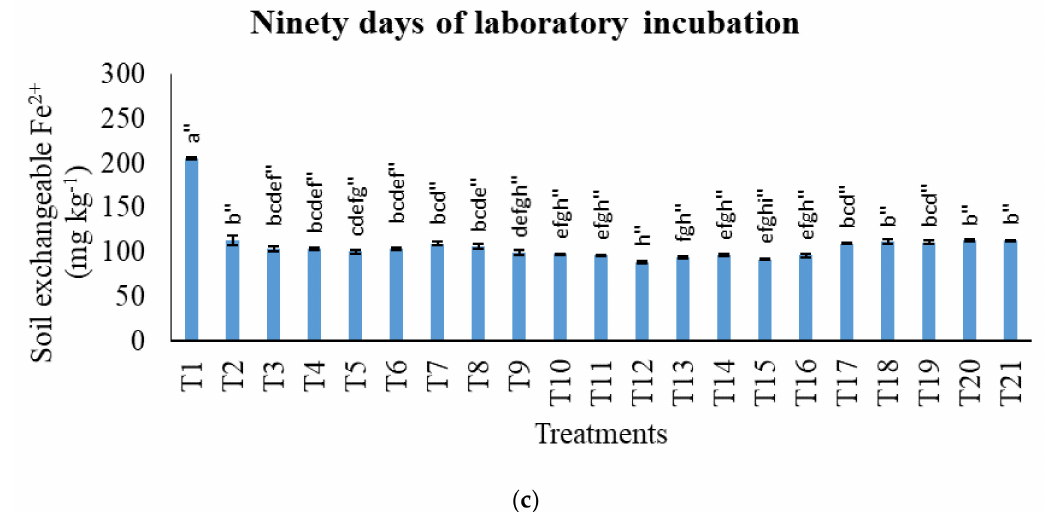
Figure 10. Effects of treatments on soil-exchangeable iron ( a ) thirty; ( b ) sixty; and ( c ) ninety days after incubation. T1: soil control, T2: conventional practice, T3: muriate of potash + 100% charcoal + 100% sago bark ash, T4: muriate of potash + 100% sago bark ash, T5: muriate of potash + 100% charcoal, T6: muriate of potash + 80% charcoal + 80% sago bark ash, T7: muriate of potash + 60% charcoal + 80% sago bark ash, T8: muriate of potash + 40% + 80% sago bark ash, T9: muriate of potash + 20% charcoal + 80% sago bark ash, T10: muriate of potash + 80 charcoal + 60% sago bark ash, T11: muriate of potash + 60% charcoal + 60% sago bark ash, T12: muriate of potash + 40% charcoal + 60% sago bark ash, T13: muriate of potash + 20% charcoal + 60% sago bark ash, T14: muriate of potash + 80% charcoal + 40% sago bark ash, T15: muriate of potash + 60% charcoal + 40% sago bark ash, T16: muriate of potash + 40% charcoal + 40% sago bark ash, T17: muriate of potash + 20% charcoal + 40% sago bark ash, T18: muriate of potash + 80% charcoal + 20% sago bark ash, T19: muriate of potash + 60% charcoal + 20% sago bark ash, T20: muriate of potash + 40% charcoal + 20% sago bark ash, and T21: muriate of potash + 20% charcoal + 20% sago bark ash. Different letters indicate significant differences between means using Tukey’s HSD test at p ≤ 0.05. The error bars are the ± standard error of triplicates. Letters without any marks and letters with ‘ and ” indicate mean comparison within thirty, sixty, and ninety days after incubation,